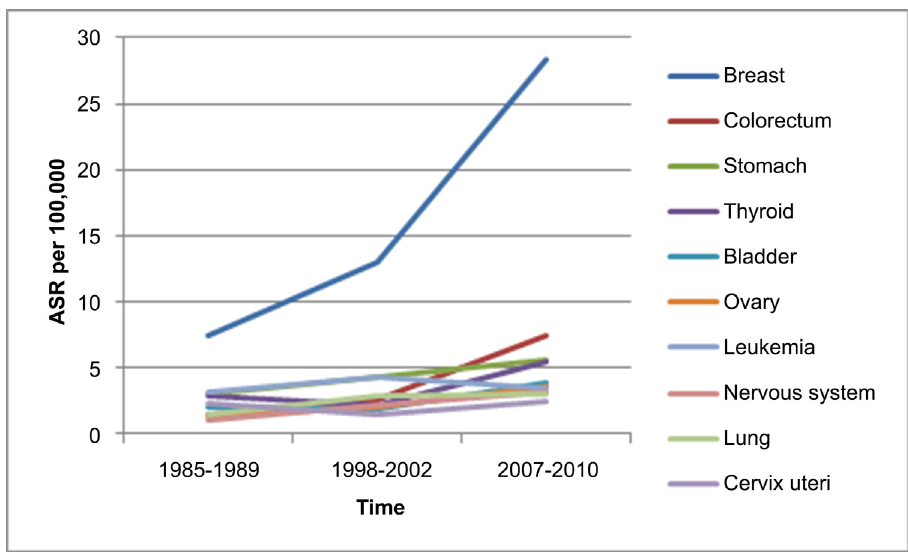
Fig 2. Changing the incidence of top ten cancers in women based on age-standardized rates per 100,000 person-years (ASR) in Fars province, Iran during three time periods. This figure shows changes in the incidence of top ten cancers in women based on age-standardized rates per 100,000 person-years (ASR) in Fars province, Iran during 1985 – 1989, 1998 – 2002, and 2007 – 2010 time